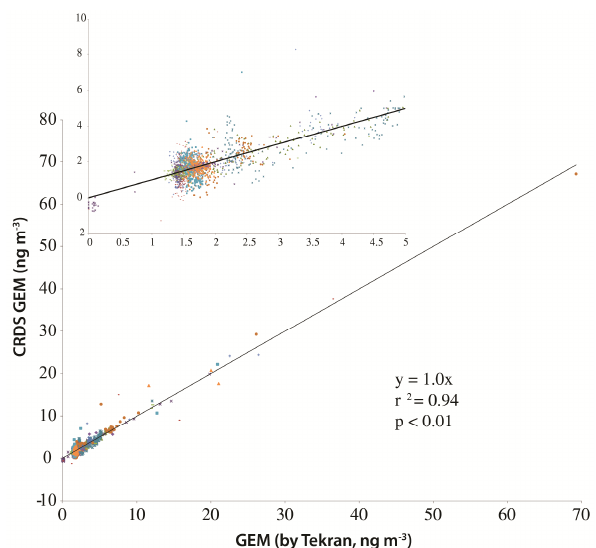
Fig. 8. Comparison of real-time, continuous concentration measure- ments between the CRDS system (calculated GEM concentrations from differential extinction in ng m − 3 ) and a commercially avail- able GEM sensor (GEM concentrations in ngm − 3 ) that operates with a 2.5min time resolution. The graph shows the whole dataset of measurements made in ambient air with spikes at various concen- trations of GEM using a GEM permeation source. Different sym- bols and colors represent the 10 days of testing. Inset shows data between 0 and 5ngm − 3 .